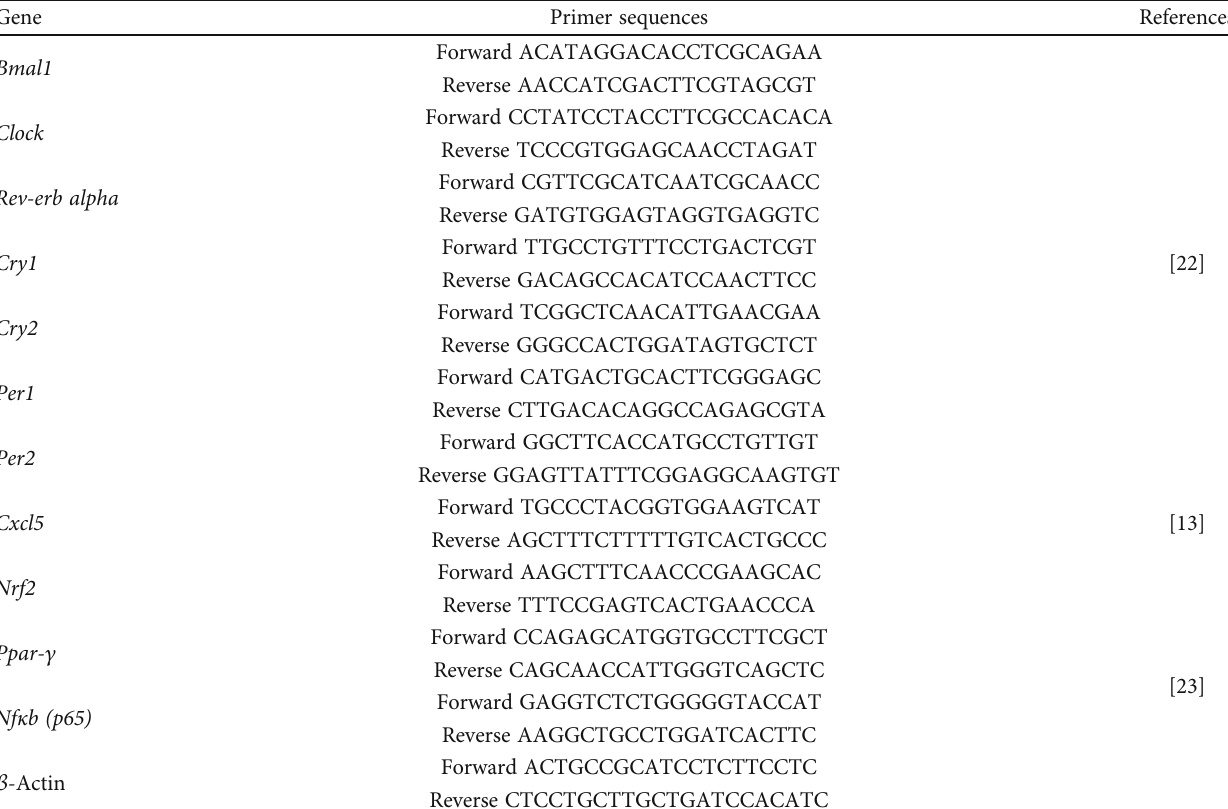
Table 1: Primer sequences for mRNA